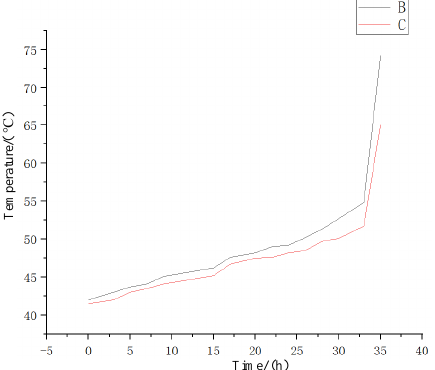
Figure 11. Temperature comparison between the gear test bench equipment operation and the state monitoring system simulation.